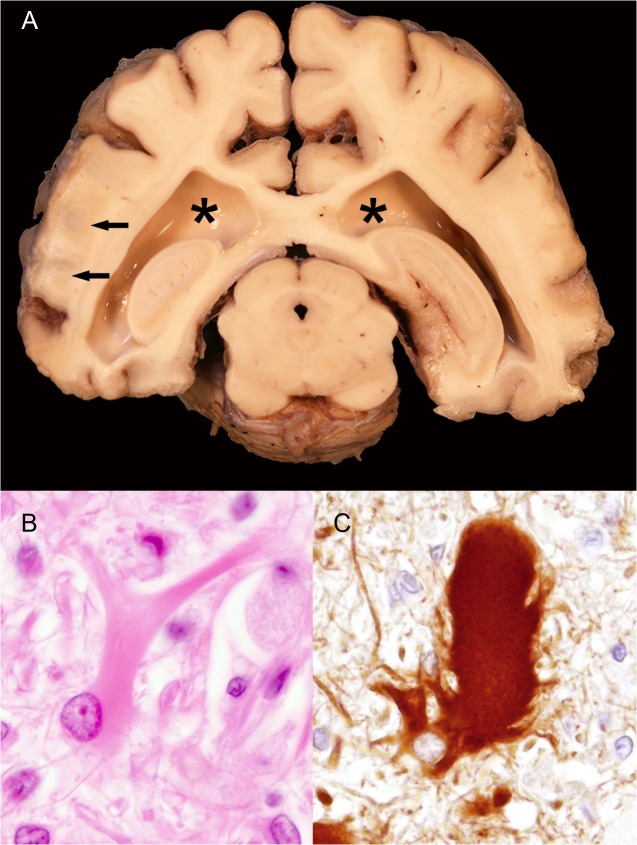
Pathologic features of large felid leukoencephalomyelopathy.A) Cerebrum, tiger, 22 years, female (animal no 29). Large felid leukoencephalomyelopathy characterized by bilateral dilatation of the lateral ventricles (asterisks) and malacic foci within the white matter (arrows). B) Cerebrum, white matter, tiger, 22 years, female (animal no 29). Gemistocytic astrocyte with prominent cytoplasmic processes and abundant homogenous eosinophilic cytoplasm. C) Cerebrum, white matter, tiger, 22 years (animal no 29), female. Gemistocytic astrocyte with a cytoplasmic positive GFAP (glial fibrillary acidic protein)-reaction. GFAP, immunohistochemistry, ABC, DAB-method.